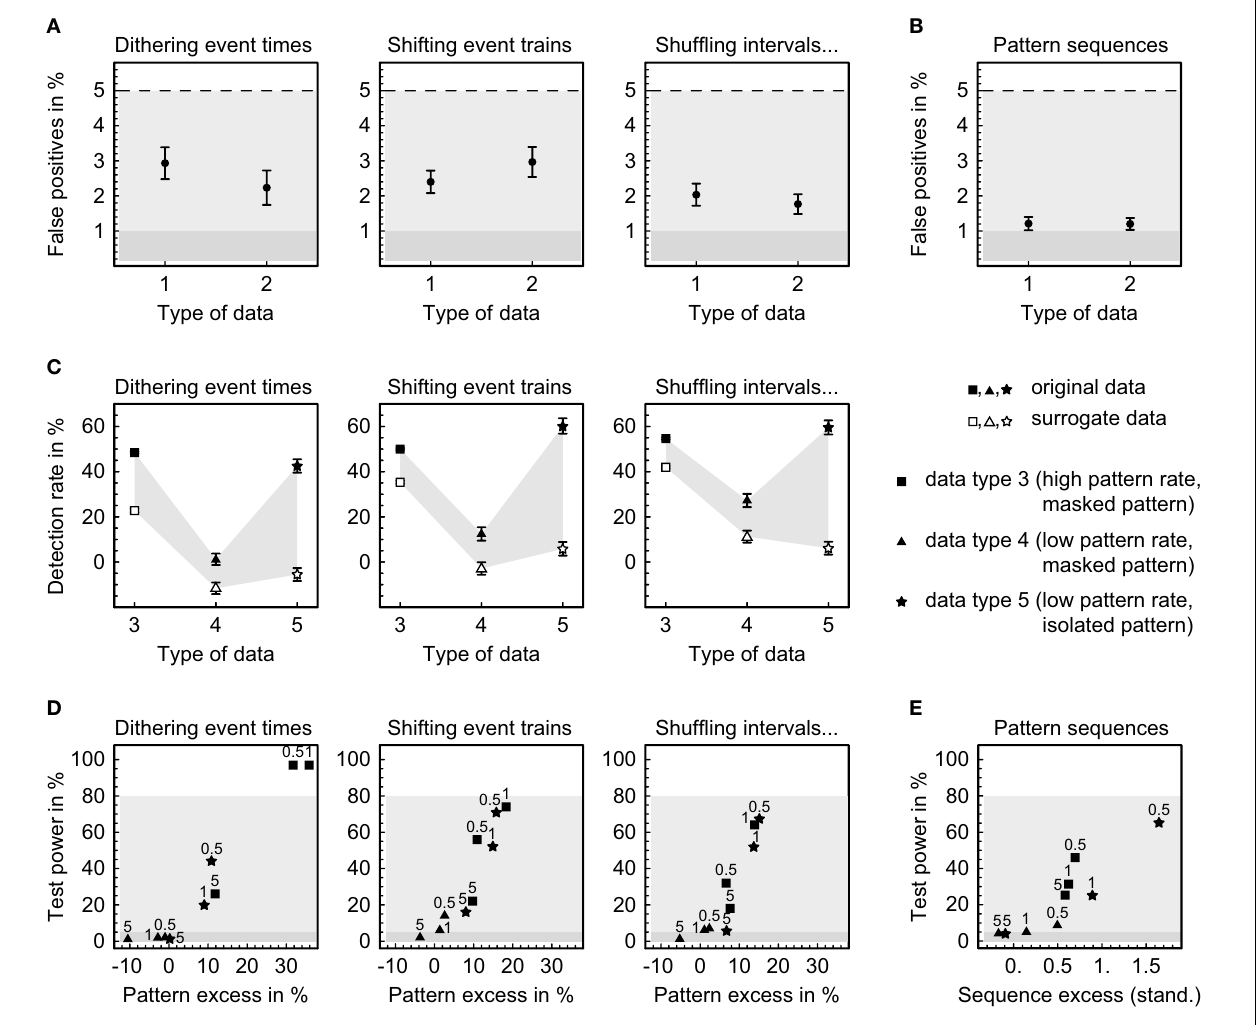
analyzing pattern sequences using the same pattern definitions as in (A) three times each. (C) Detection rates of spatiotemporal patterns (mean ± SEM) calculated as the difference of significant pattern counts from data with and without additional patterns, normalized with respect to the number of inserted patterns, and averaged across 100 data sets using three different pattern definitions (5ms window, timing precisions of 10 bins, 5 bins, and rank order). (D) Test power for an excess of spatiotemporal patterns using a window W of 5ms and timing precisions τ of 0.5, 1, and 5ms (rank order) as indicated (excess averaged across 100 data sets). (E) Test power for an excess of pattern sequences using the same parameters as in (D) (excess displayed as the standardized mean difference and averaged across 300 data